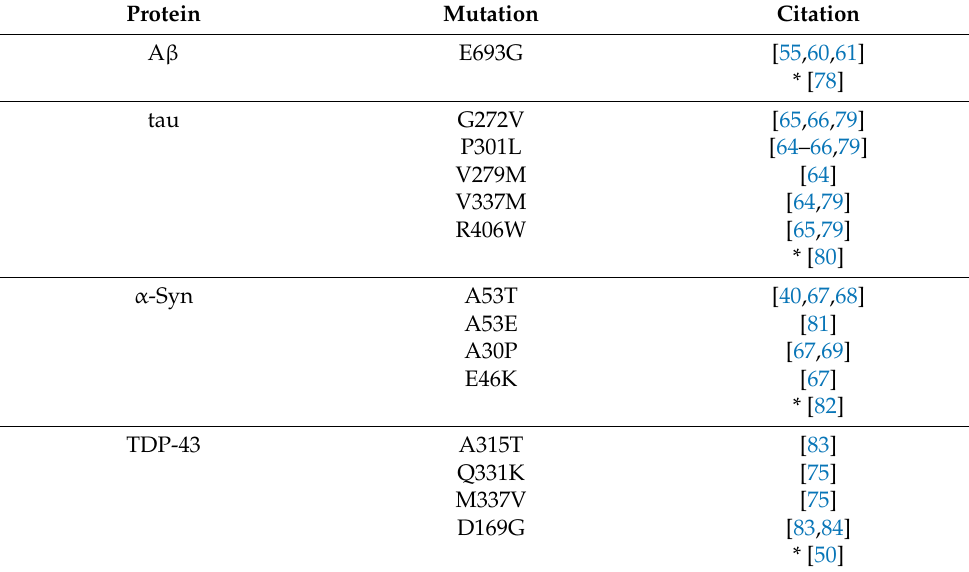
Table 1. Mutations associated with